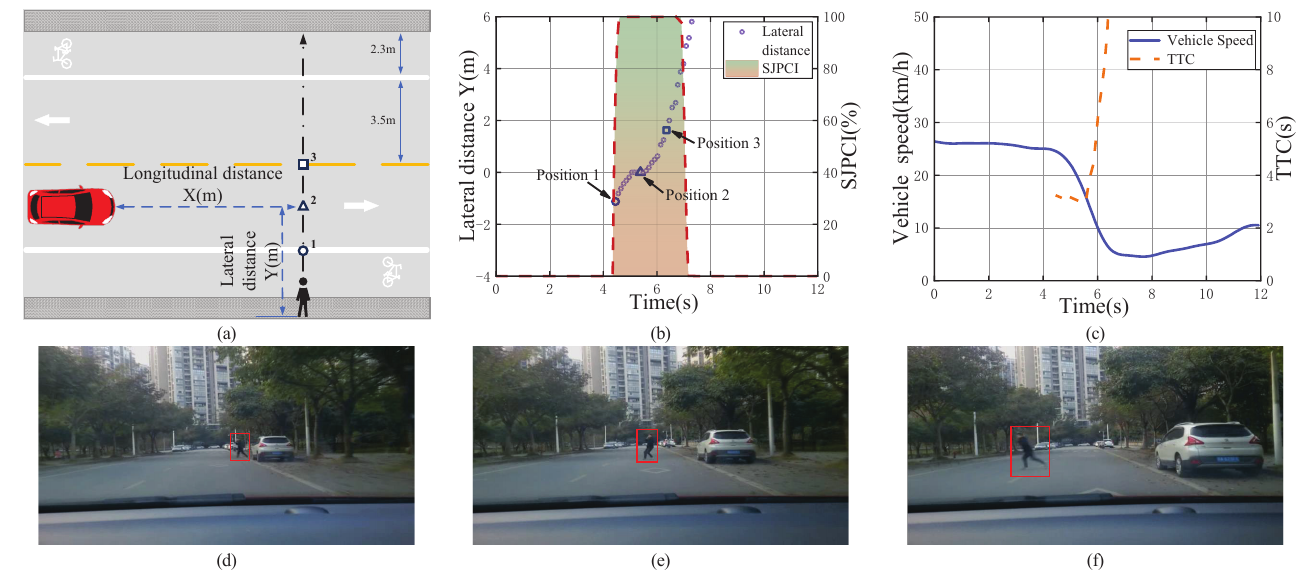
Figure 9. A severe deceleration event when encountering a pedestrian crossing the street and the data analysis results. ( a ) Pedestrian–vehicle interaction schematic diagram; ( b ) Lateral distance and SJPCI; ( c ) Vehicle speed and TTC; ( d ) Position 1: Pedestrian suddenly appeared from behind a vehicle; ( e ) Position 2: Pedestrian had seen the approaching vehicle; ( f ) Position 3: Pedestrian ran to cross the